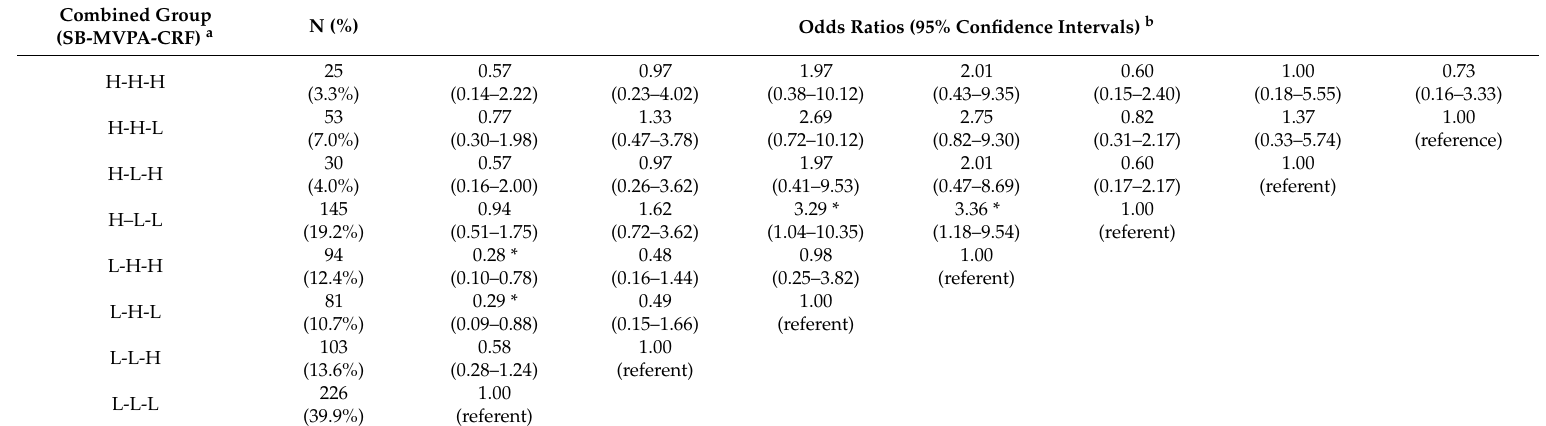
Table 4. Fully-Combined Associations of SB, MVPA and CRF with Sleep